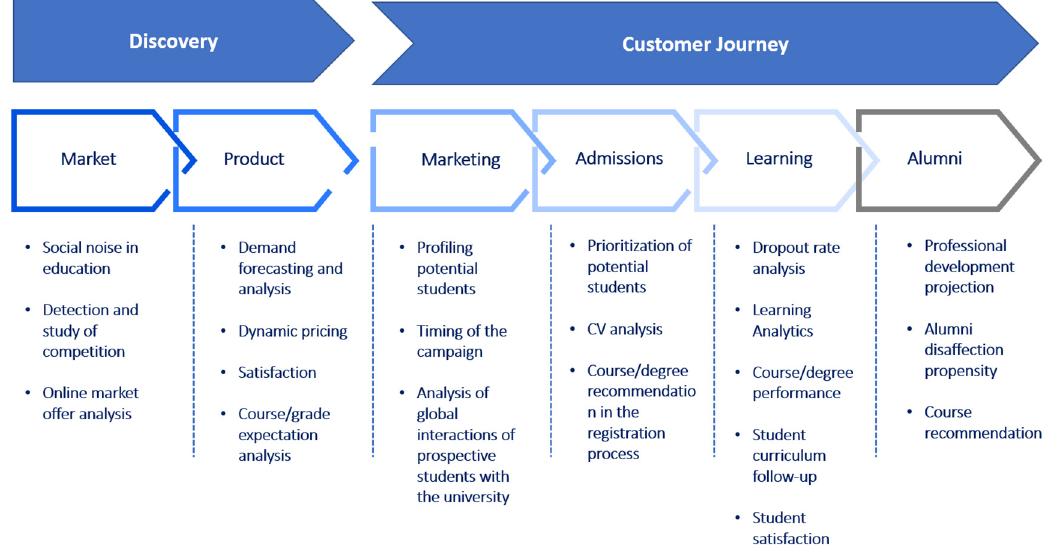
Figure 10. Value chain of a university institution and potential projects in which to apply models based on Artificial Intelligence. Source: own elaboration.